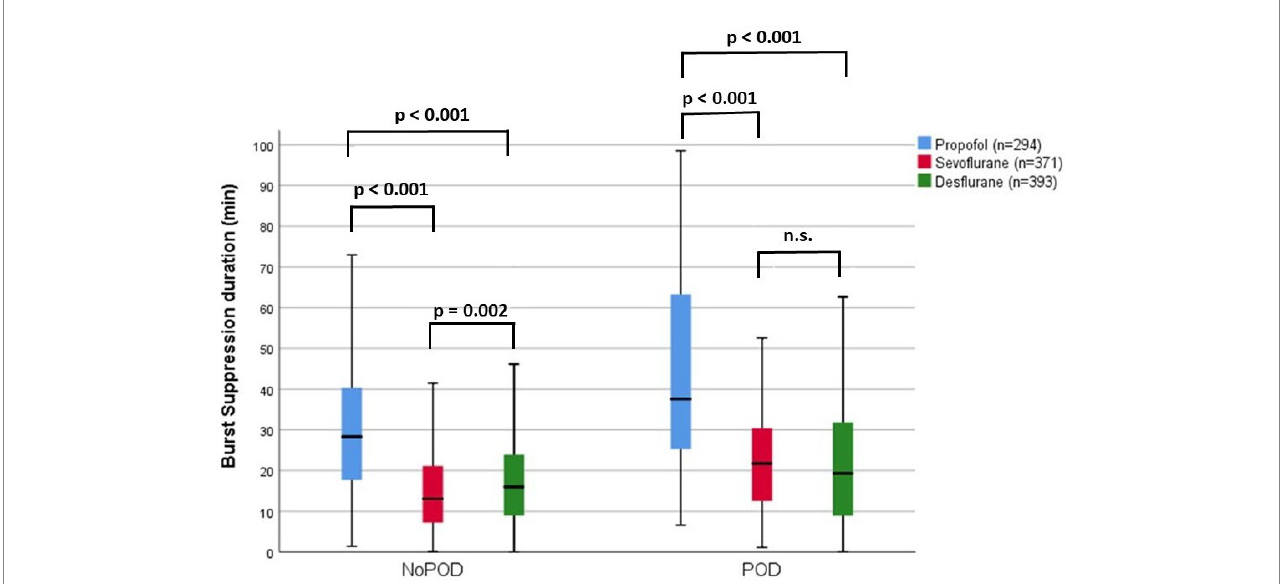
FIGURE 2 Intraoperative burst suppression duration (min) within the NoPOD and POD group within for different anesthetic agents given during anesthesia maintenance. Burst suppression duration were within the propofol group in NoPOD patients: 30.8 + 18.9 min, range 1.4 to 132.8 min and POD patients: 44.1 + 25 min, range 6.6 to 98.5 min; within the sevoflurane group in NoPOD patients: 15.8 + 11.5 min, range 0.1 to 64.1 min and POD patients: 23.9 + 15.4 min, range 1.1 to 80.7 min; within the desflurane group NoPOD patients: 19.1 + 14.2 min, range 0 to 73.6 min and POD patients: 23.3 + 20.0 min, range 0 to 133